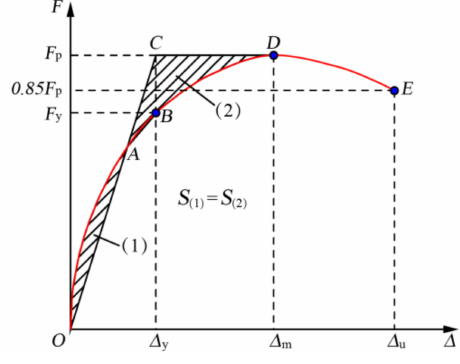
Figure 9. Diagram of energy equivalent method. Table 4. Measured load and displacement at characteristic